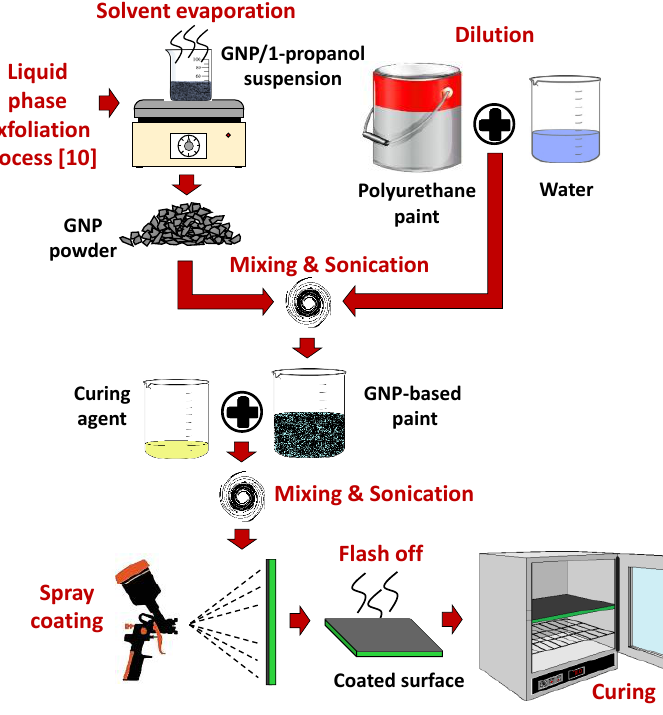
Figure 1. Sketch of the GNP–PU paint production steps.